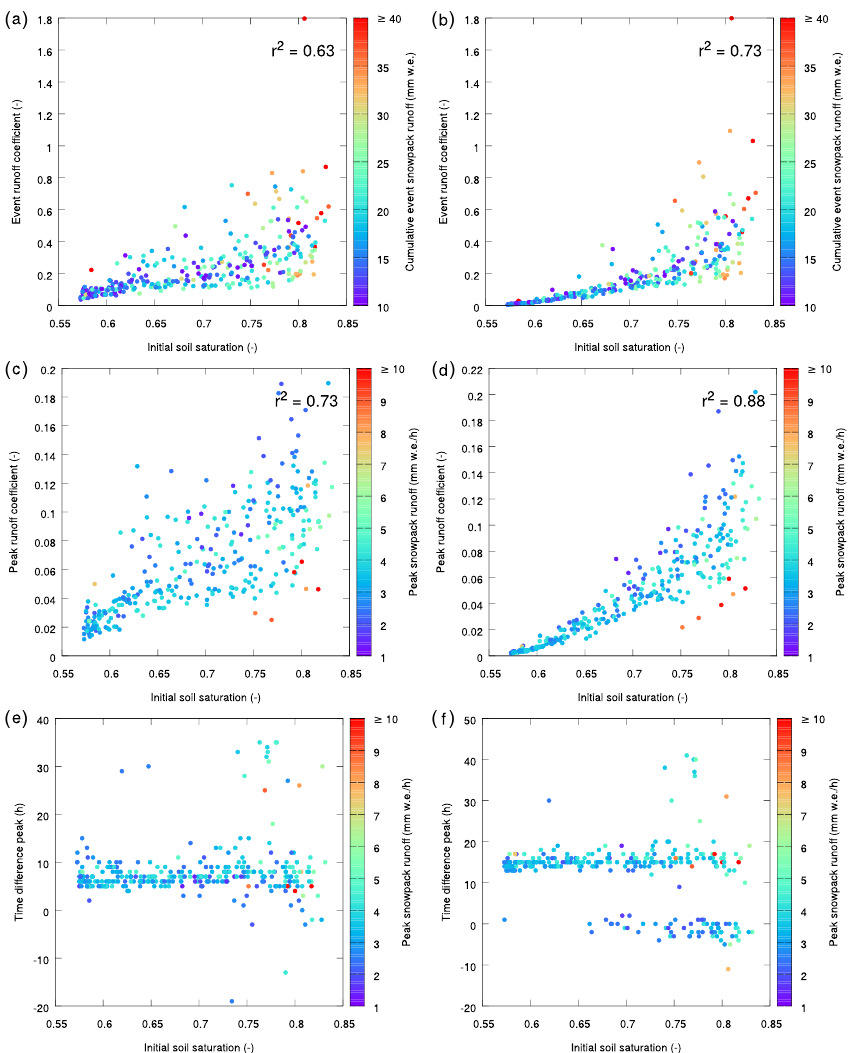
Figure 12. Snowpack runoff event runoff coefficients for measured discharge as a function of initial soil saturation in the upper 40cm of the soil (a) and similar results for simulated discharge (b) . Peak snowpack runoff coefficients for measured discharge as a function of soil saturation (c) and similar results for simulated discharge (d) . Time difference between peak snowpack runoff and measured peak discharge (e) and similar results for simulated peak discharge. Points are coloured according to the event snowpack runoff sum (a, b) or the peak snowpack runoff (c, d, e, f)